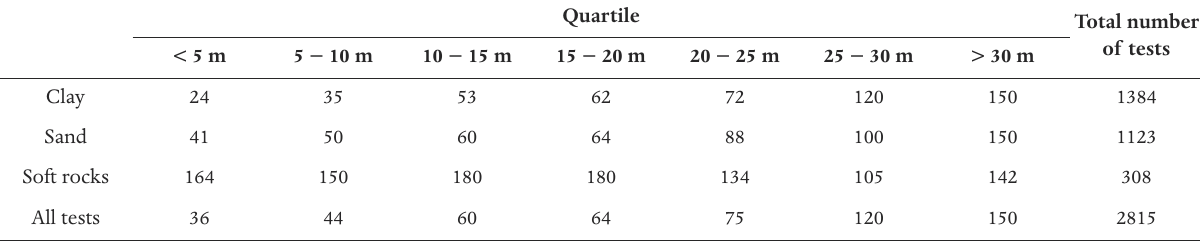
values of the different lithologies in the Miocene Table 3. Median of N SPT